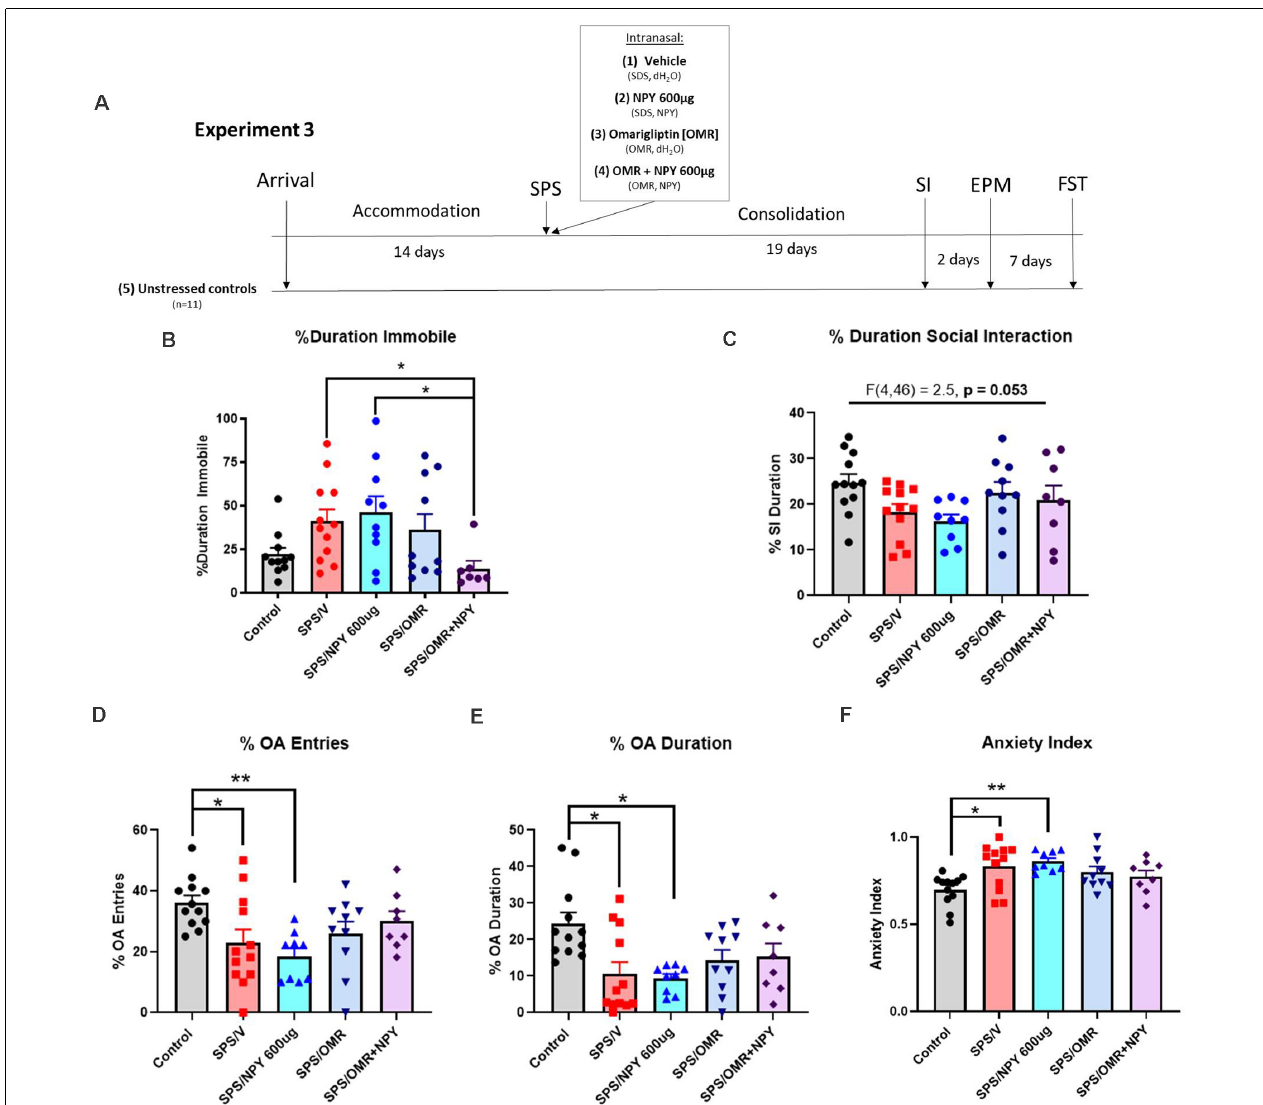
FIGURE 4 | Effects of NPY processing on the high dose requirement for prevention of stress-elicited behavior. The experimental protocol is shown (A) . Animals were infused intranasally with either the vehicle for OMR and NPY (SPS/V), NPY 600 µ g (SPS/NPY 600 µ g ), dipeptidyl peptidase IV inhibitor omarigliptin (SPS/OMR), or both (SPS/OMR+NPY) immediately after the SPS stressors. The SPS/NPY 600 µ g and SPS/OMR groups also received the vehicle for the other drug treatment given as separate infusions (SDS = OMR vehicle; dH 2 O = NPY vehicle). Alongside unstressed controls, the animals were tested for social interaction, anxiety on the EPM, and depressive-like behavior on the FST 19, 21, and 28 days after the SPS stressors, respectively. The animals were measured for (B) percent duration immobile on the FST and (C) percent duration social interaction. On the EPM, animals were tested for (D) percent entries into the open arms (OA); (E) percent duration in the OA; (F) anxiety index. Each point represents values for an individual animal. Means ± SEM are shown. One-way ANOVA was performed and post hoc Tukey was used to determine differences between groups. * p < 0.05, ** p <